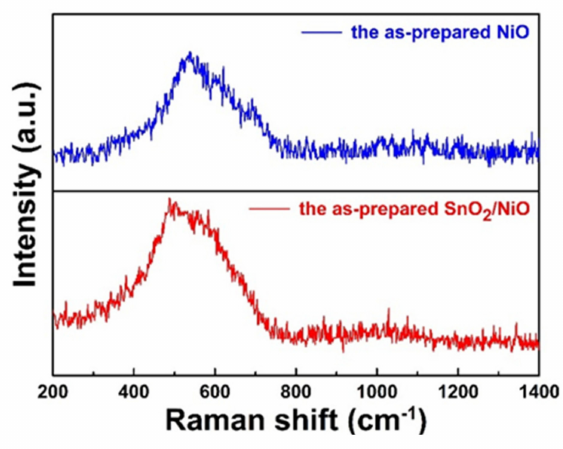
Figure 4. Raman scattering spectra of the pristine NiO and SnO 2 / NiO